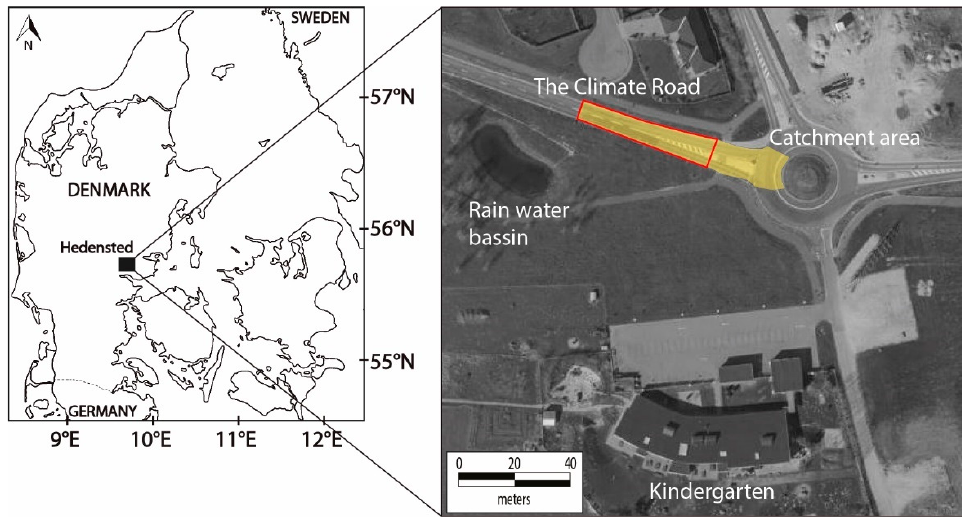
Figure 1. Overview map.